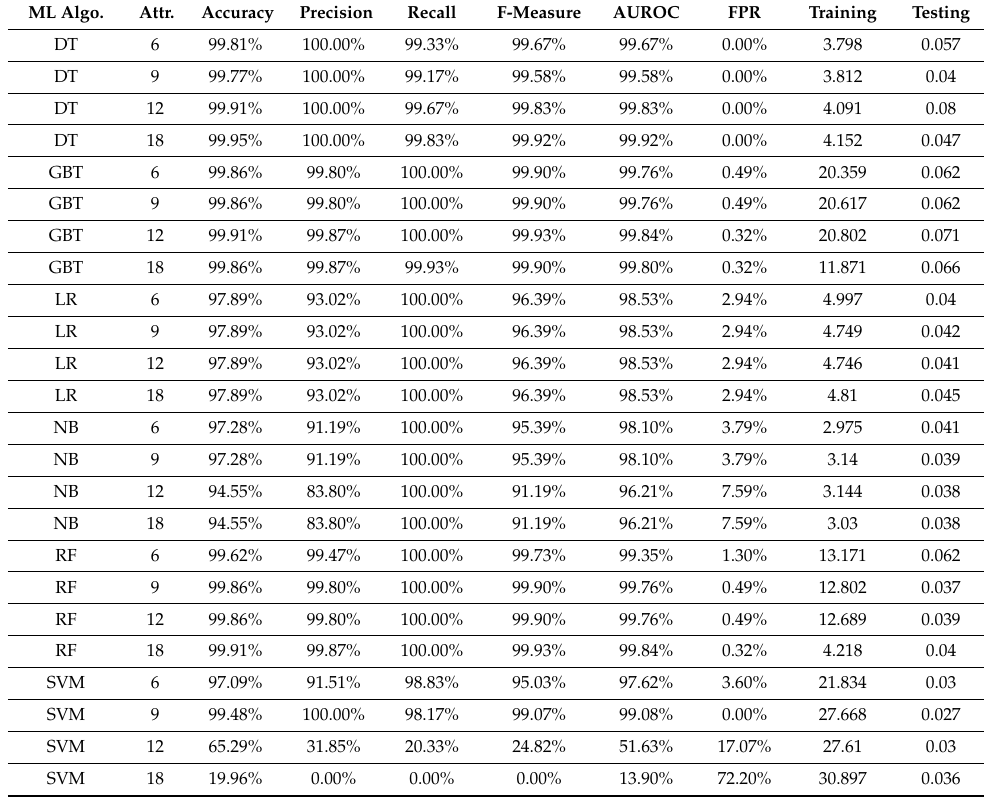
Table 20. Discovery: Performance of the various machine learning classifiers. ML